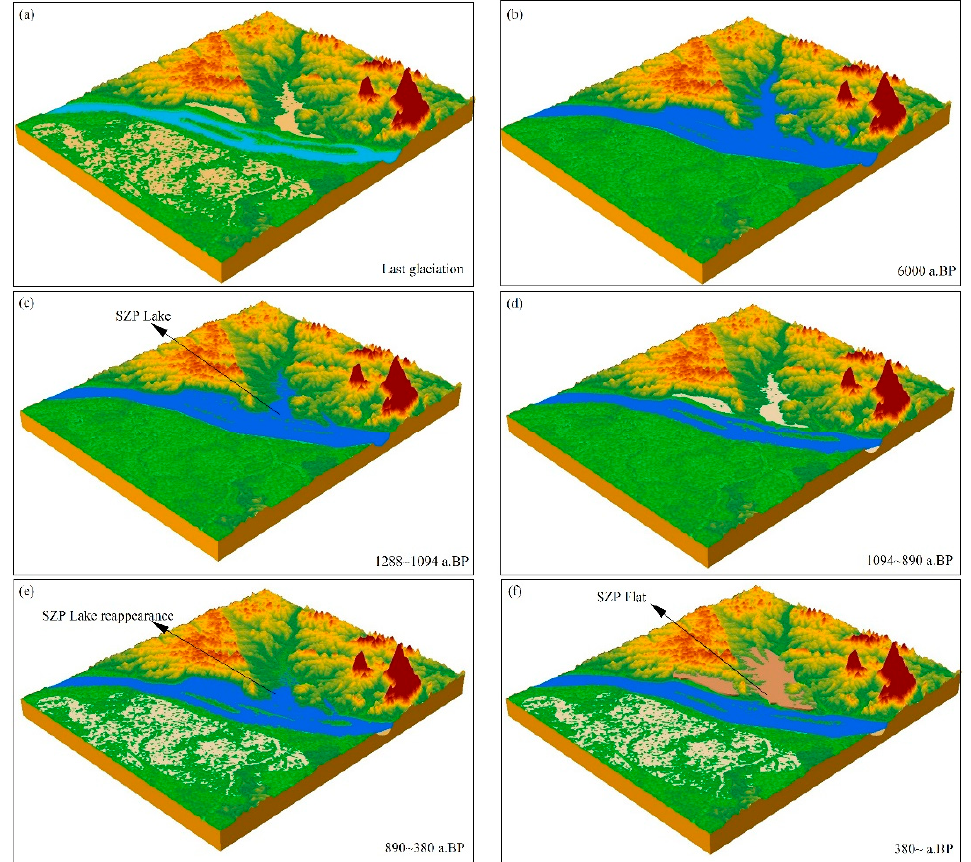
Figure 6. Evolution of the palaeohydrological environment in the Xiangjiang River basin. ( a ): During the last glacial period, the watershed was a river − cut plain landscape. ( b ): At 6000 a.BP, the Yangtze River reached its highest water level. ( c ): 1288–1094 a.BP, the climate was warm and humid. The Xiangjiang River was at a high − water period, and lakes appeared in the Changsha Kiln area. ( d ): 1094–890 a.BP, the climate turns dry and cold. The water level of the Xiangjiang River dropped, the lake disappeared, and the floodplain appeared. ( e ): 890–380 a.BP, the Xiangjiang River bed was raised, the water level rose, and a shallow lake appeared in the kiln area. ( f ): 380–a.BP, Dikes were built in the Changsha kiln area and flats were formed around the SZP profile.